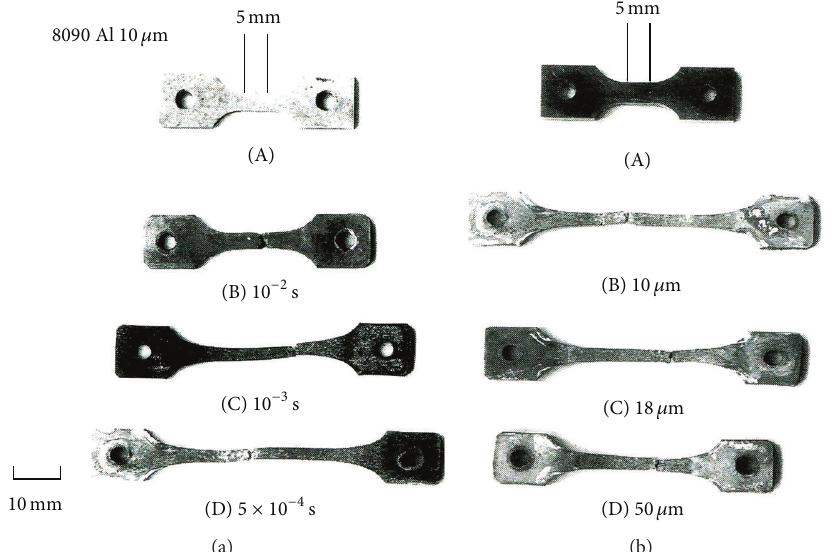
Figure 7: Tensile test results of 8090 Al-Li alloy obtained at 530 ∘ C by varying the (a) strain rates and (b) grain sizes. A is untested specimen in both cases.